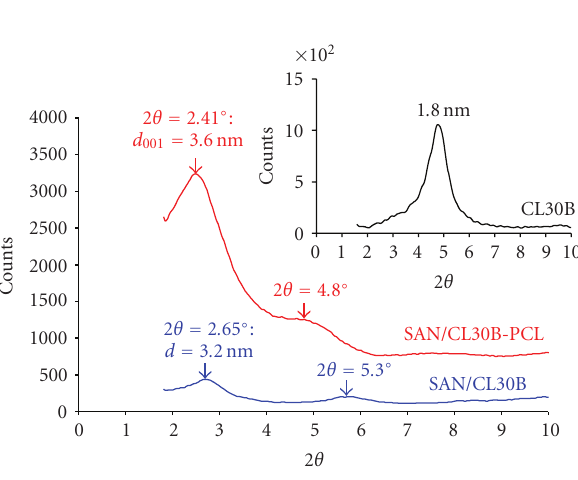
Figure 1: WAXD patterns of SAN/CL30B and SAN/CL30B-PCL with 3wt% of inorganics. The inset shows the pattern for the pristine